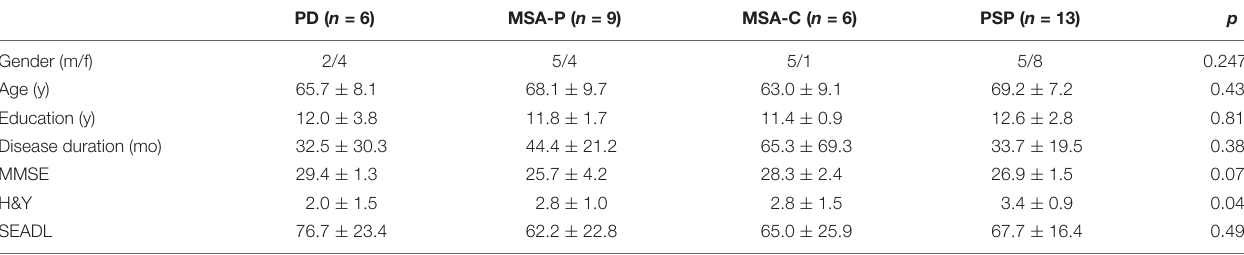
TABLE 1 | Demographic and clinical data of the study